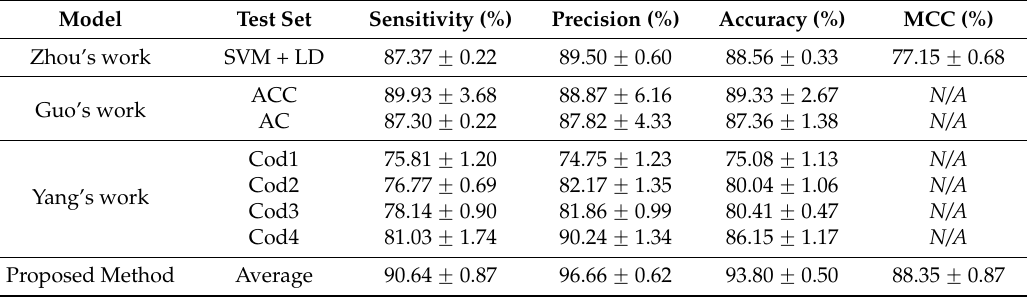
Table 4. Comparison of other methods on the S. cerevisiae dataset.